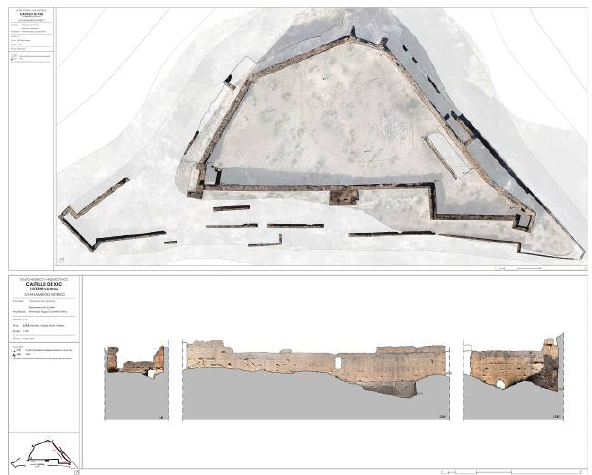
Fig. 4. Drone survey: Castle of Xió, Llutxent (Valencia, Spain)